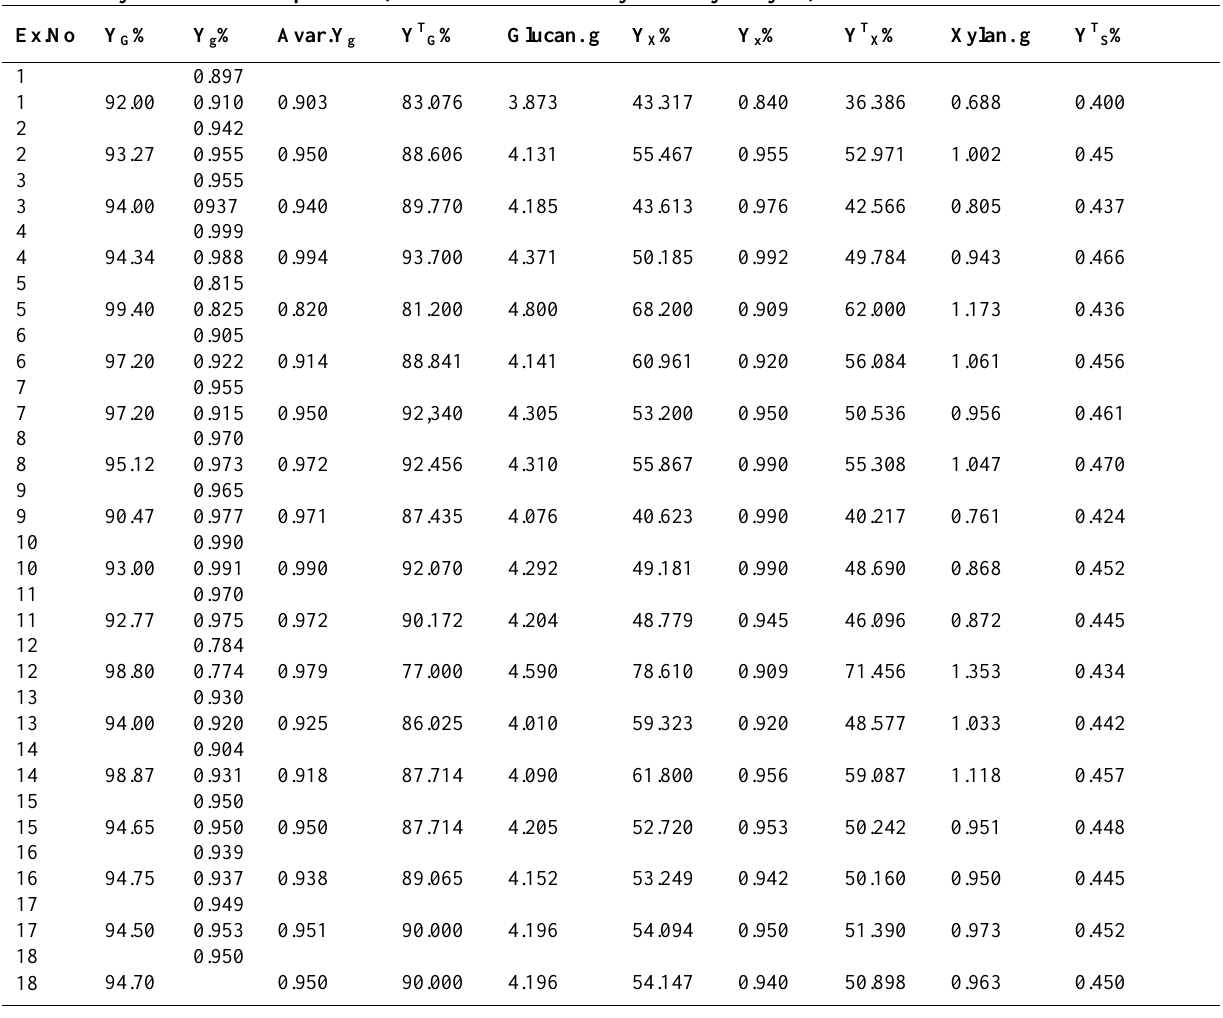
Different yields of overall process (Pretreatment and enzymatic